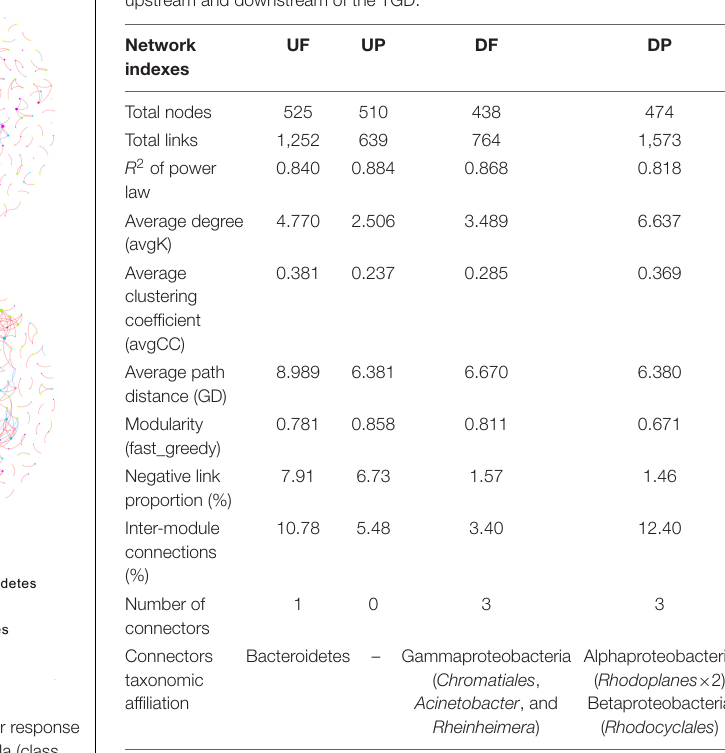
TABLE 1 | Topological properties of free-living and particle-attached networks upstream and downstream of the TGD.